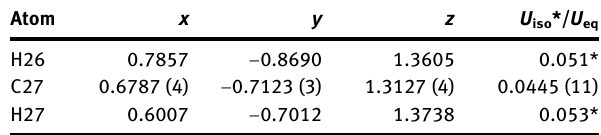
Table  : Fractional atomic coordinates and isotropic or equivalent isotropic displacement parameters (Å 